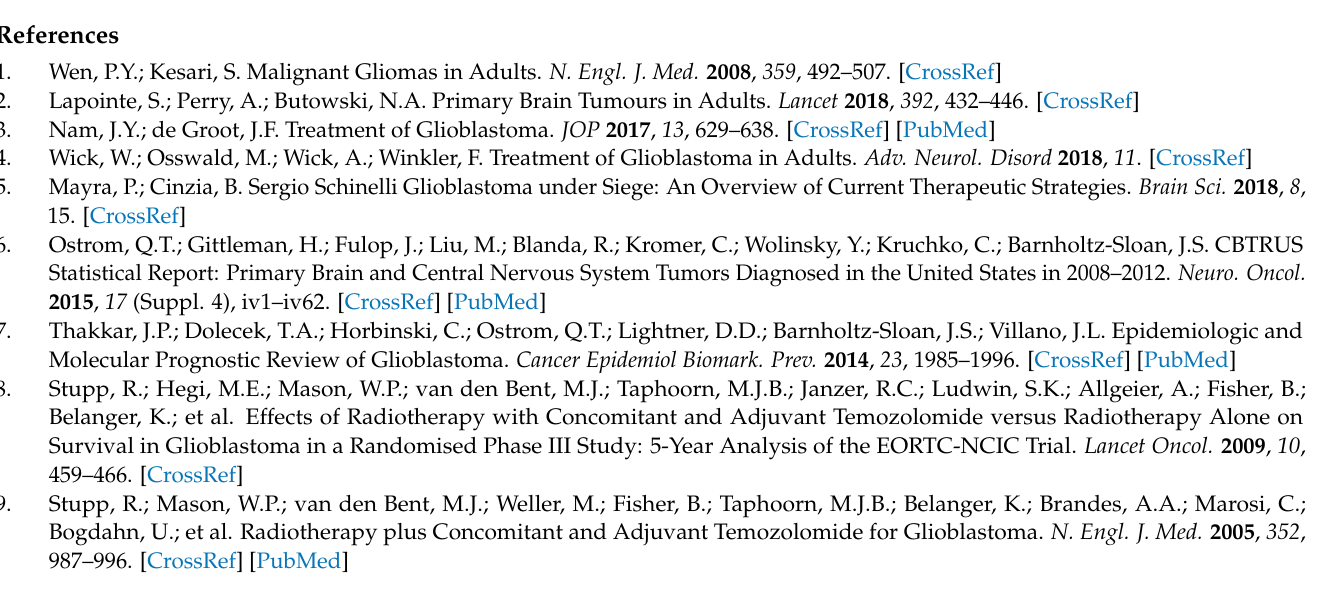
classification models on PFS, Table S1: Cross-validation results ( ± 1 std deviation) for the different machine-learning algorithms, Table S2: Results of the binary